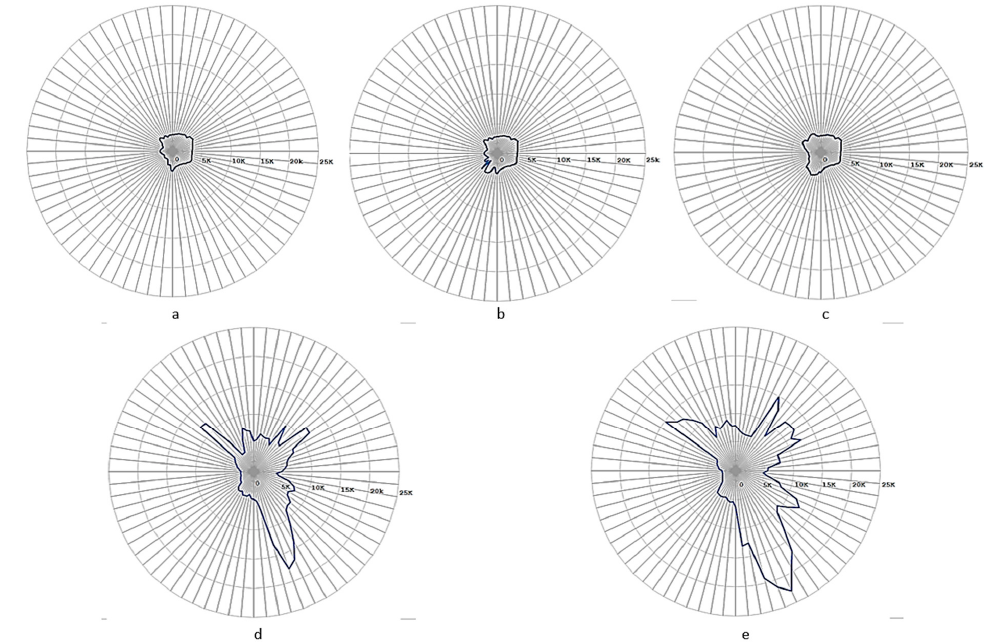
Figure 7. The succession of growth radiuses at θ = 5-degree angles for the years: 1975, 1985, 1995, 2005, and 2015, ( a – e ) respectively.